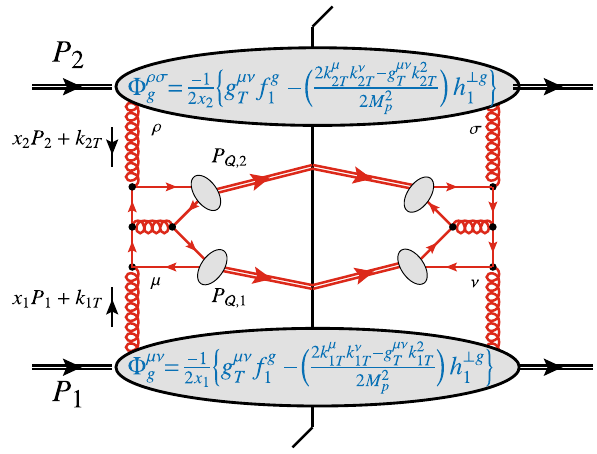
Fig. 1 Representative Feynman graph for p ( P 1 ) + p ( P 2 ) → ) + Q ( P Q , ) + X via gluon fusion at LO in TMD Q ( P Q , 1 2